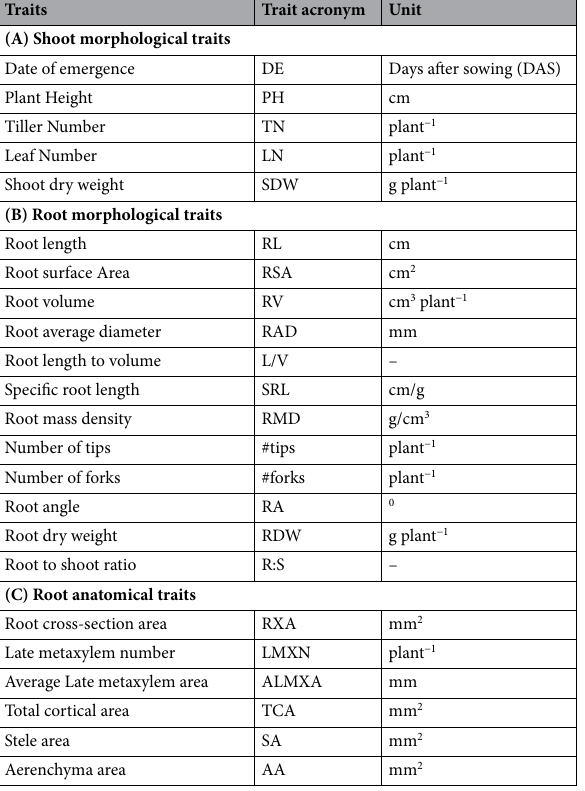
Table 1. List of studied and derived phenotypic traits with trait acronym and